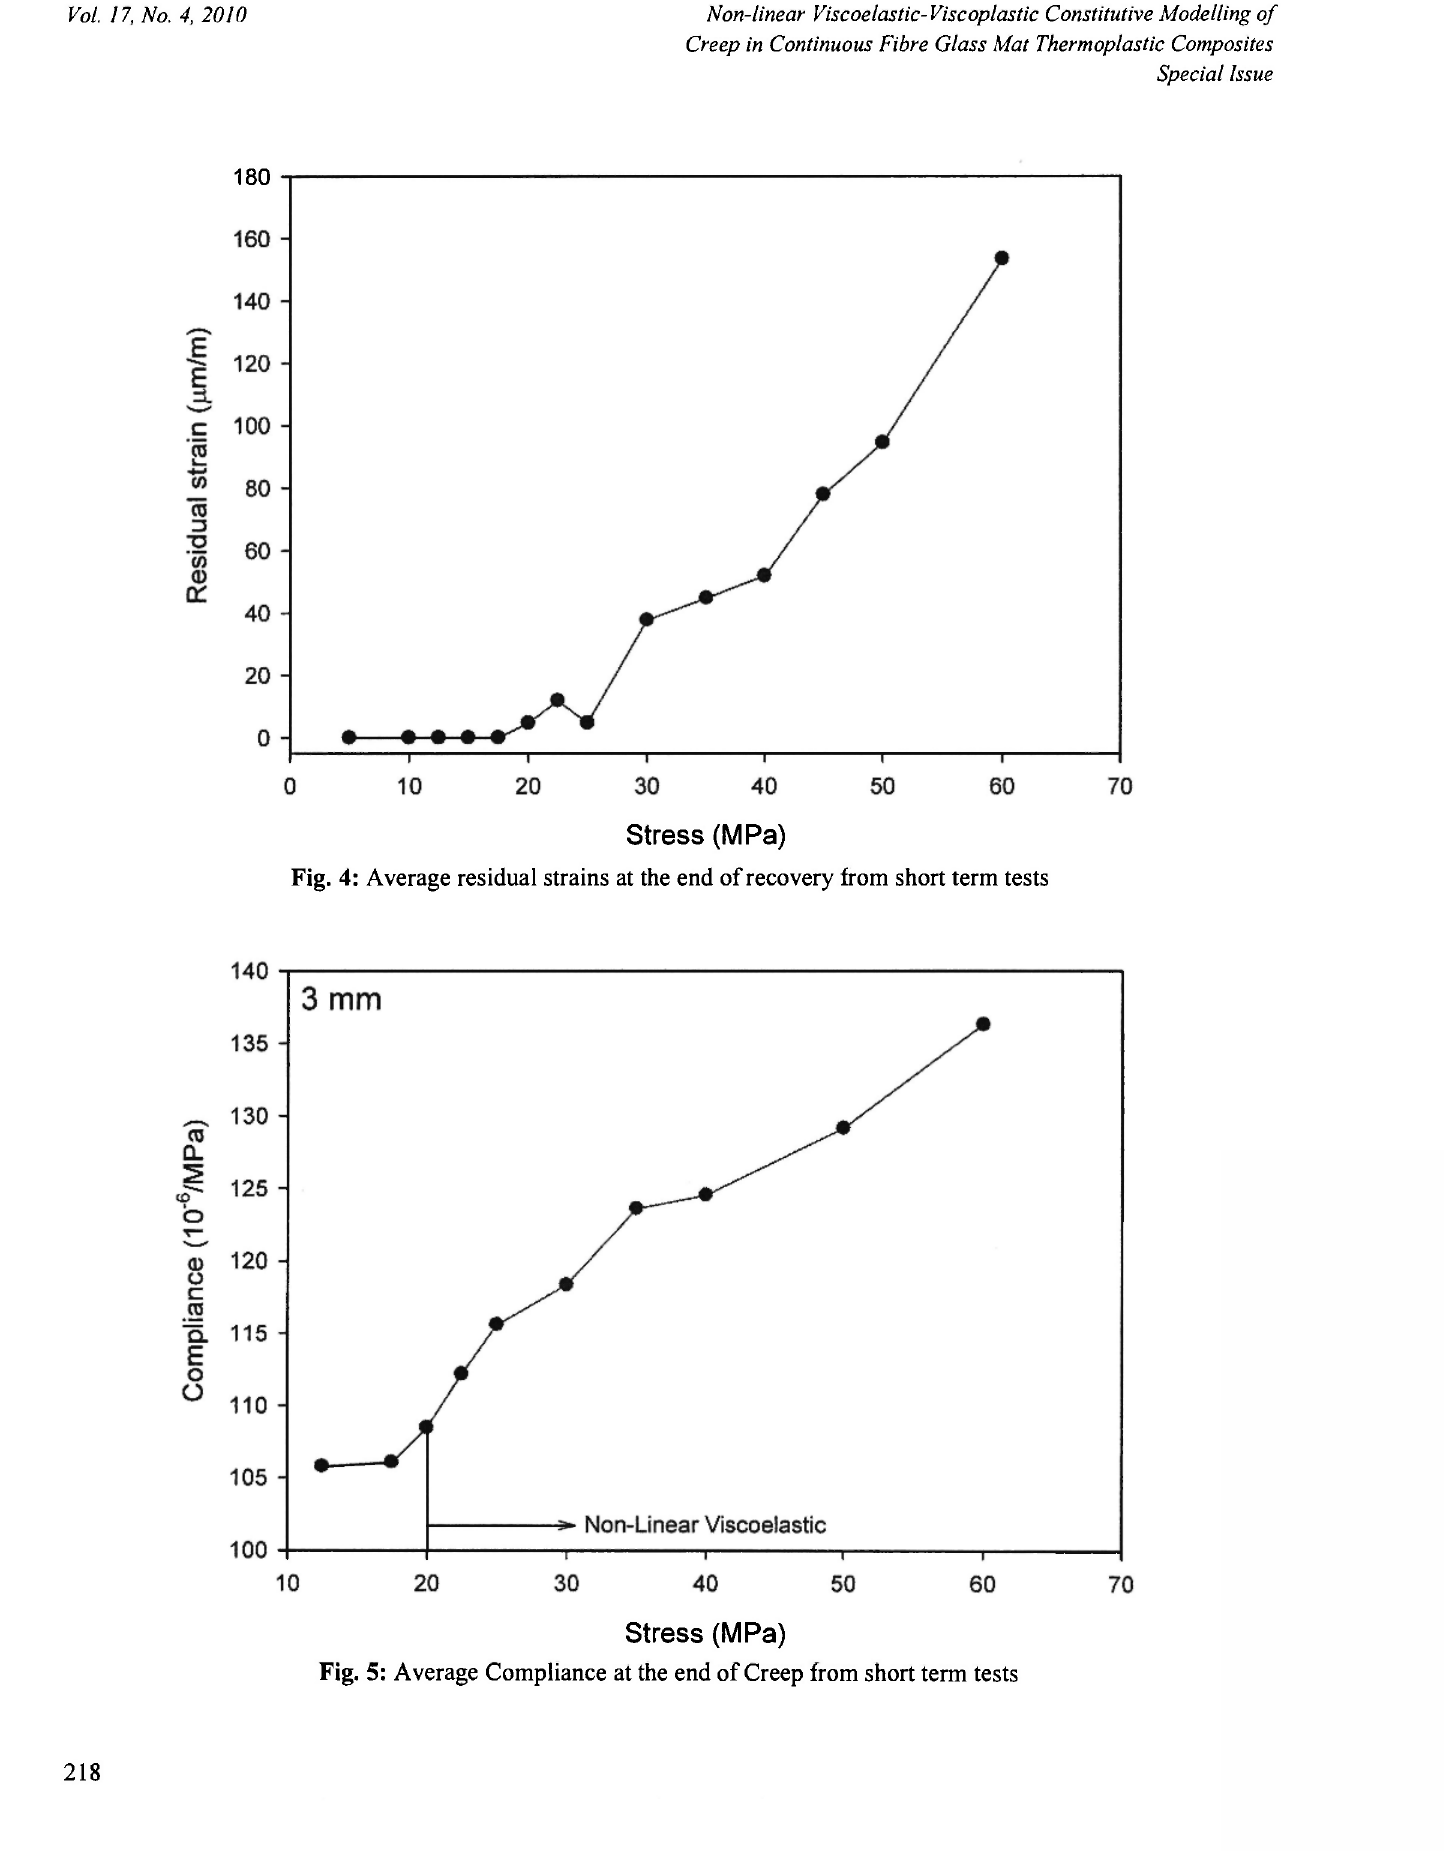
Fig. 4: Average residual strains at the end of recovery from short term tests